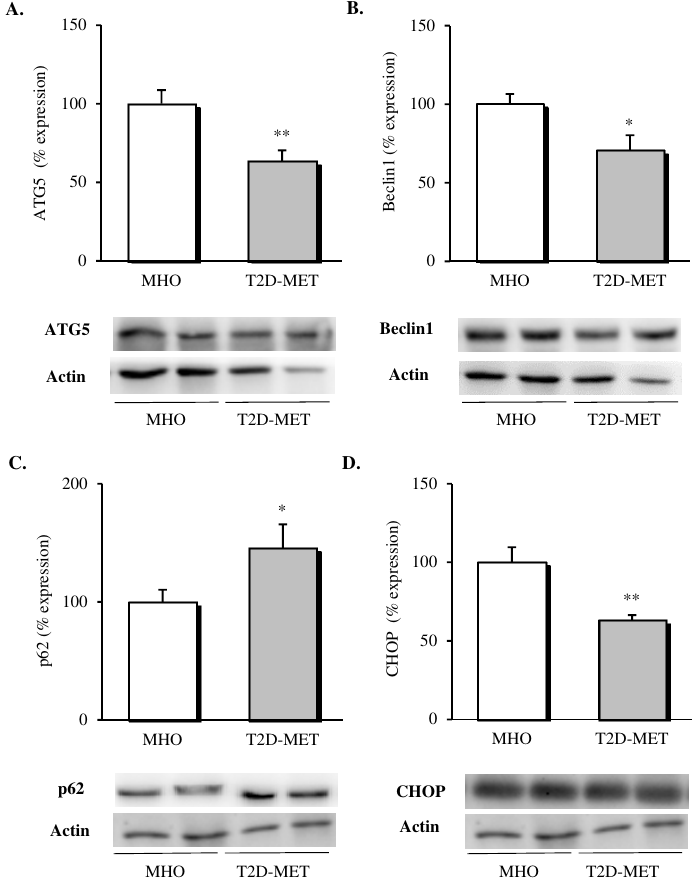
Figure 3. Evaluation of autophagy mediators and CHOP in the VAT of MHO and obese T2D